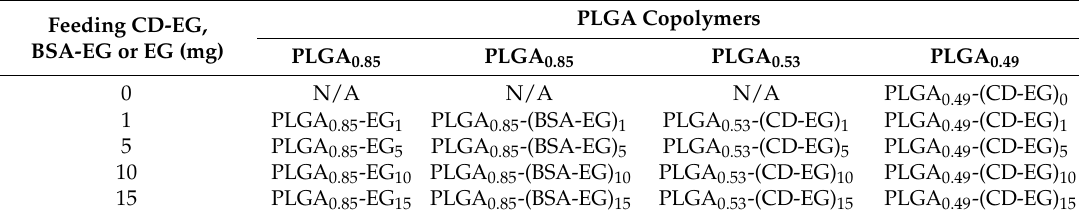
Table 2. Abbreviations of the various PLGA microspheres with different initial amounts of CD-EG, BSA-EG, or EG. In this study, the molar ratio of CD to EG or BSA to EG in the CD-EG or BSA-EG complexes used was